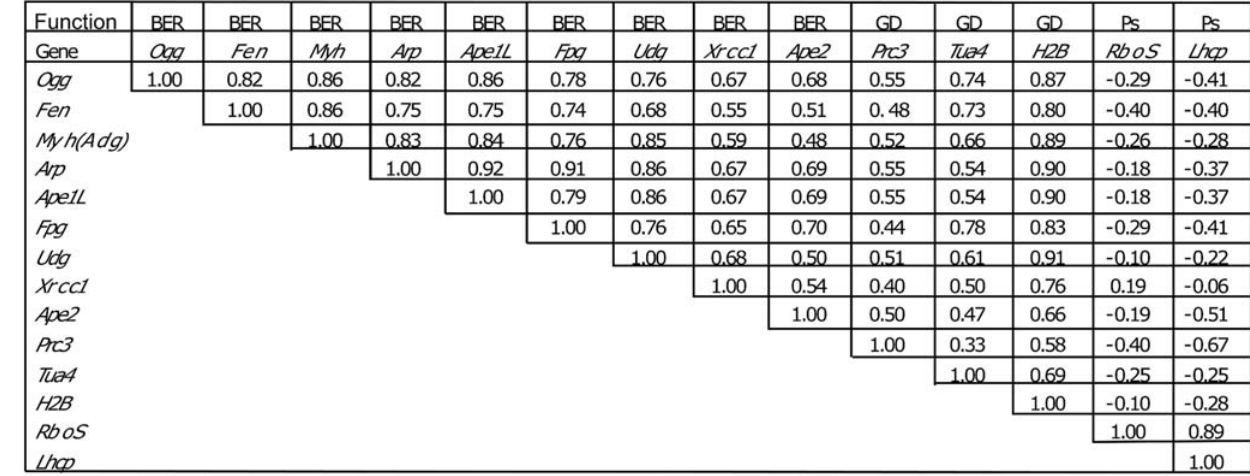
Figure 4. Correlations between genes related to DNA repair, growth and development, and photosynthesis. Correlations between the expression levels of genes in different organs and stages of development were calculated from the Arabidopsis Genome Expression data set in TAIR. Abbreviations: BER, genes of the base excision repair pathway: OGG , oxoguanine glycosylase (At1g21710); Fen , flap endonuclease (At5g26680); Myh , MutY homologue (adenine-DNA glycosylase, At4g12740); Arp , abasic endonuclease-redox protein (At2g41460); Ape1L , abasic endonuclease-1-like (At3g48425); Fpg , formamidopyrimidine-DNA glycosylase (At1g52500); Udg , uracil-DNA glycosylase (At3g18630); XRCC-1 , X-ray repair complementing defective repair in Chinese hamster cells-1 (At1g80850); Ape2 , abasic endonuclease 2 (At4g36050). GD: growth and development genes: Prc3 , proteasome subunit a2 (At1g16470); Tua4 , tubulin A4 (At1g04820); H2B , histone 2B (At1g07790). Ps: photosynthetic genes: RboS , ribulosebispho- sphate small subunit (At1g67090); Lhcp , light harvesting chloroplast protein (At1g29910). The data set contains entries for 80 organs/stages, although not all entries have data for all genes. The 95% confidence level is 6 0.18.